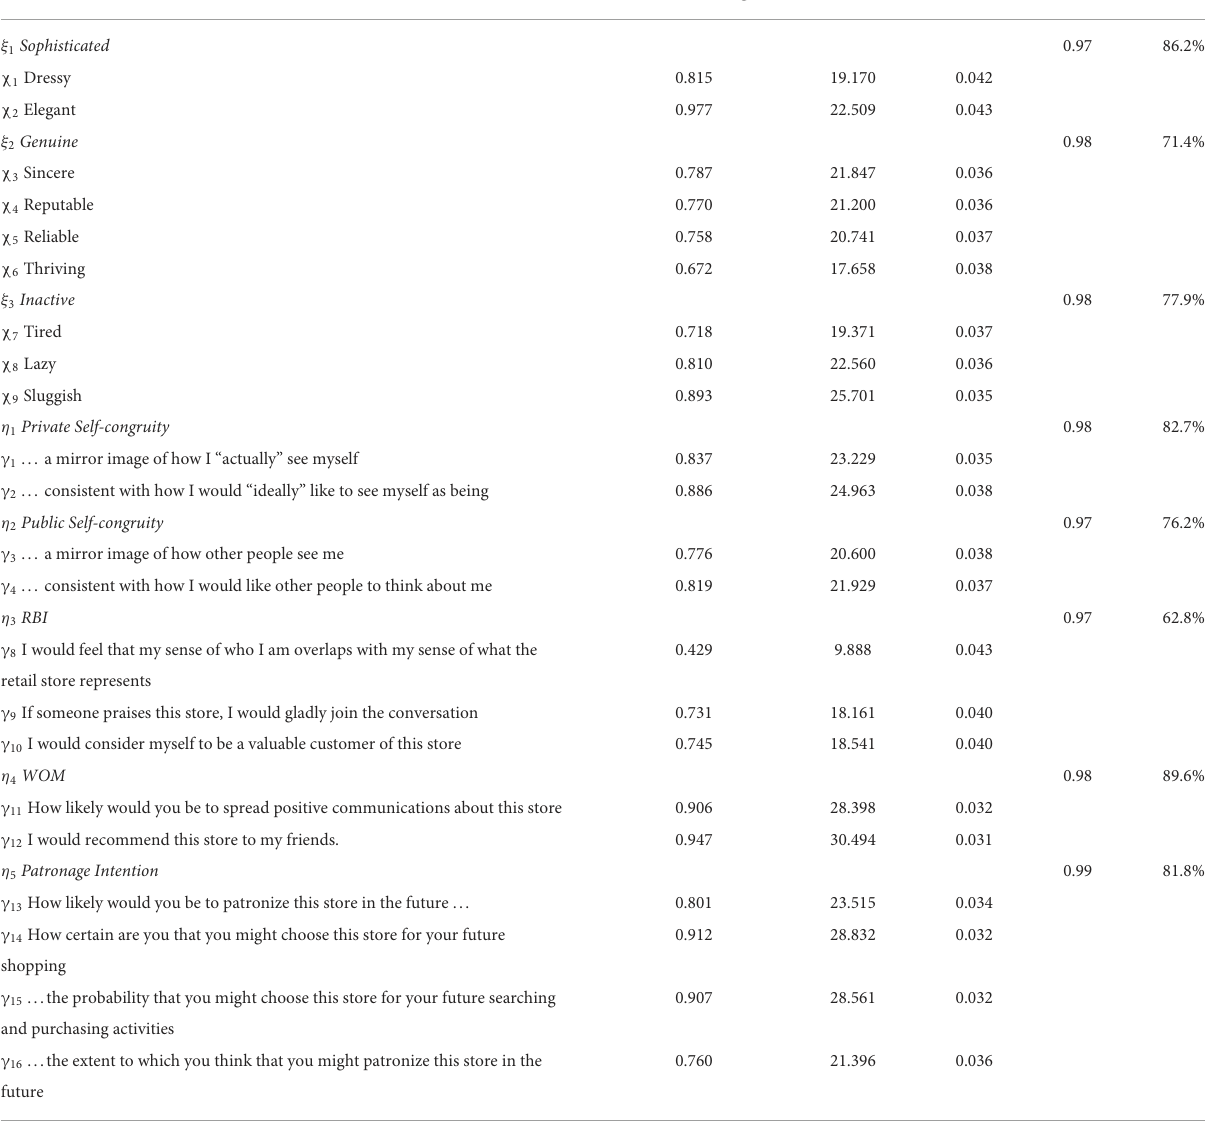
TABLE 1 Measurement model